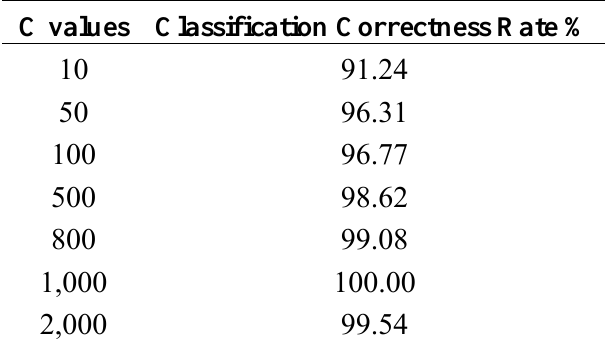
Table 3. Multiple C values with linear